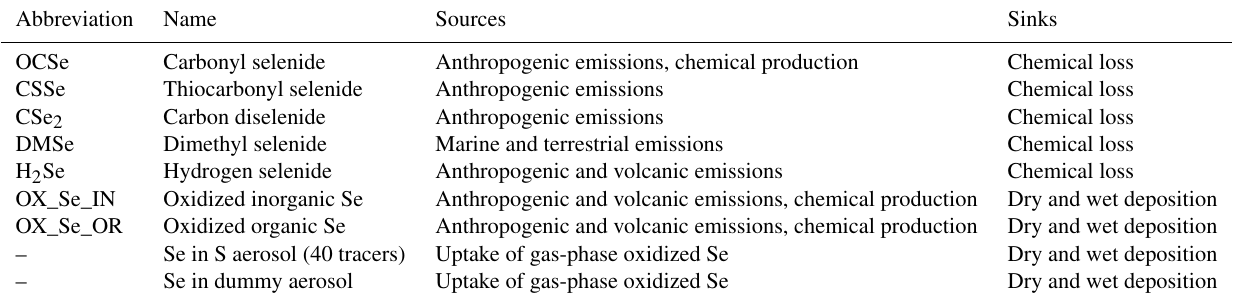
Figure 1. Scheme of the atmospheric Se cycle in SOCOL-AER, based on information in Ross (1985) and Wen and Carignan (2007). For simplicity the two oxidized Se tracers in SOCOL-AER are represented with a single box. The impact on agriculture and human health is also shown, since it motivates the study of atmospheric Se. Table 1. Description of Se tracers included in